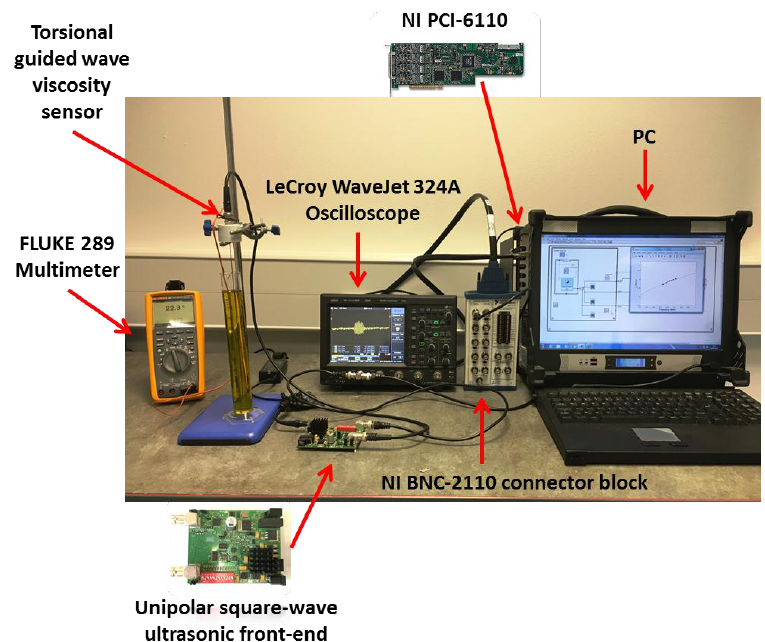
Figure 10. Unipolar ultrasonic square wave front-end experimental setup for torsional guided wave viscosity sensor.